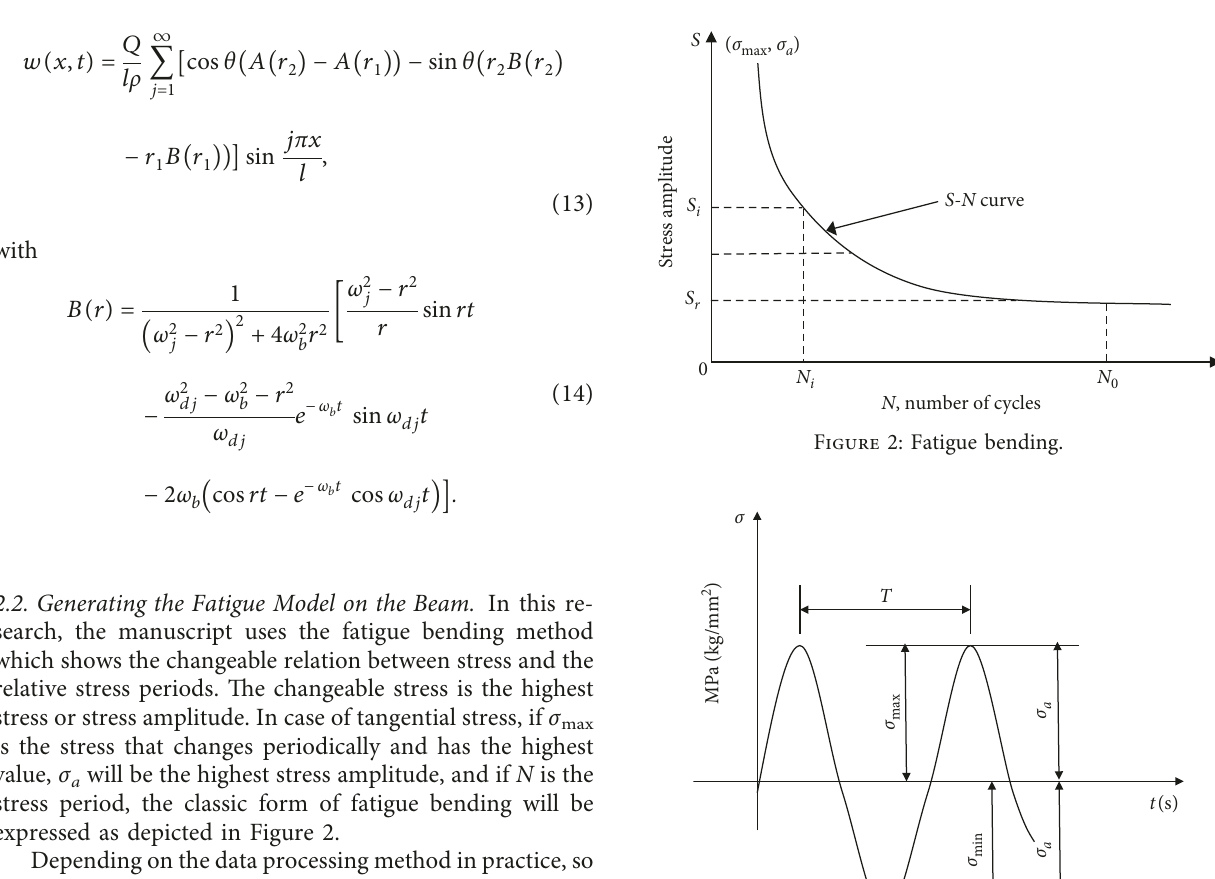
Figure 3: Symmetric stress period ( σ